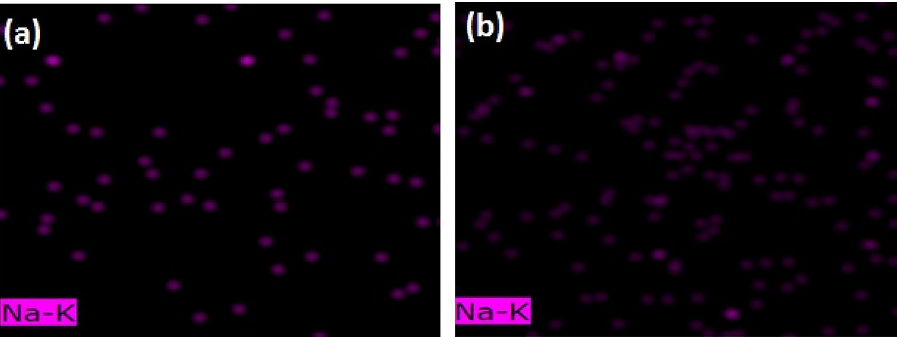
Figure 6. EDX mapping allows a qualitative comparison of the amount of sodium in tooth enamel between the control sample that received only FV and the one impregnated with FV after He-DBDJ plasma processing. The image is the result of a 2 nm enamel scan area. (a) C + FV, (b) He-DBDJ + FV.